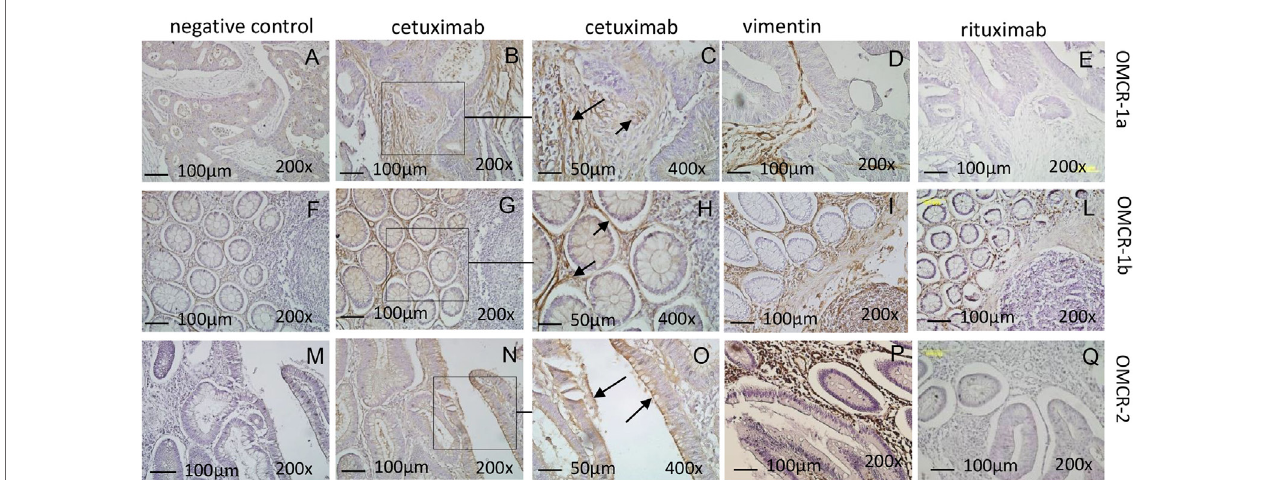
FigUre 4 | CRC tumor-associated fibroblasts express EGFR and are recognized by cetuximab at the tumor site. Reactivity of the humanized antibody cetuximab (B,c,g,h,n,O) was evaluated by immunohistochemistry on the CRC areas (OMCR-1a, upper row and OMCR-2, lower row) or the tumor free colon mucosa (OMCR-1b, middle row). Left panels (a,F,M) : negative control (anti-human antiserum alone). Upper and central rows: reactivity on mesenchymal stromal cells (MSC) [panels (B,g) and arrows in panel (c,h) ]. Lower row: reactivity on epithelial cells [panel (n) and arrows in panel (O) ]. (c,h,O) Enlargements of the squares indicated in panels (B,g,n) . MSC were identified by the specific expression of vimentin (D,i,P) . (e,l,Q) Reactivity of the control antibody rituximab. Data are representative of specimens from carcinoma or tumor free mucosa of six different patients. Images were taken with the Leica microscope DM MB2 microscope equipped with a charged coupled device camera (Olympus DP70); images were taken at 200 × and 400 ×